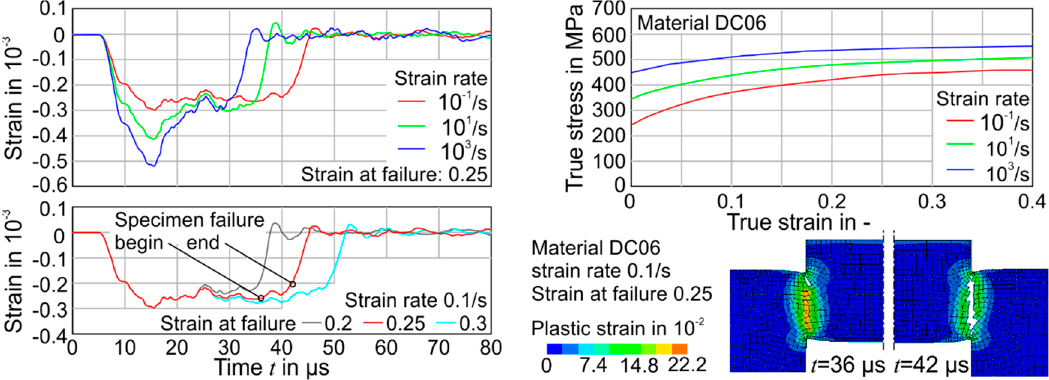
Figure 10. Sensitivity of the strain signal to yield stress and failure strain.